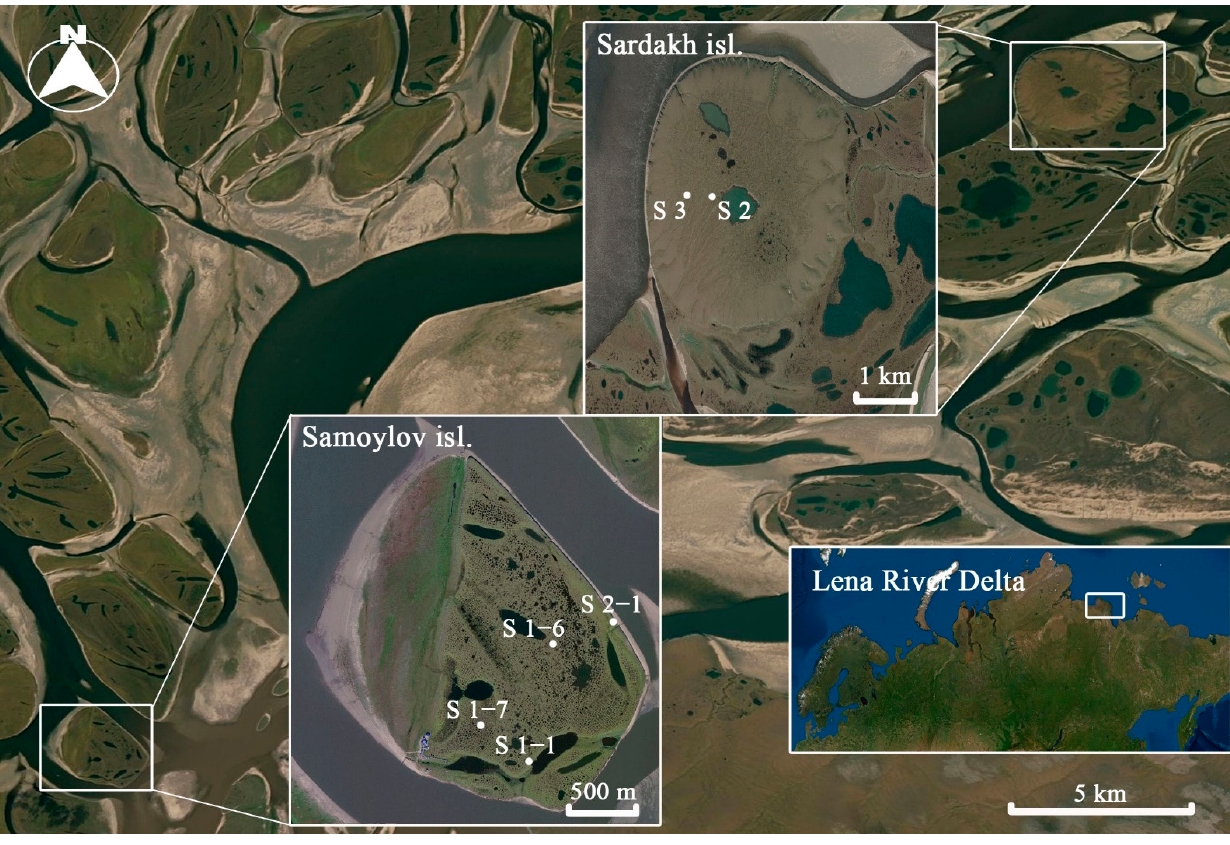
Figure 1. Study area. Lena River Delta, Siberia, Russia.